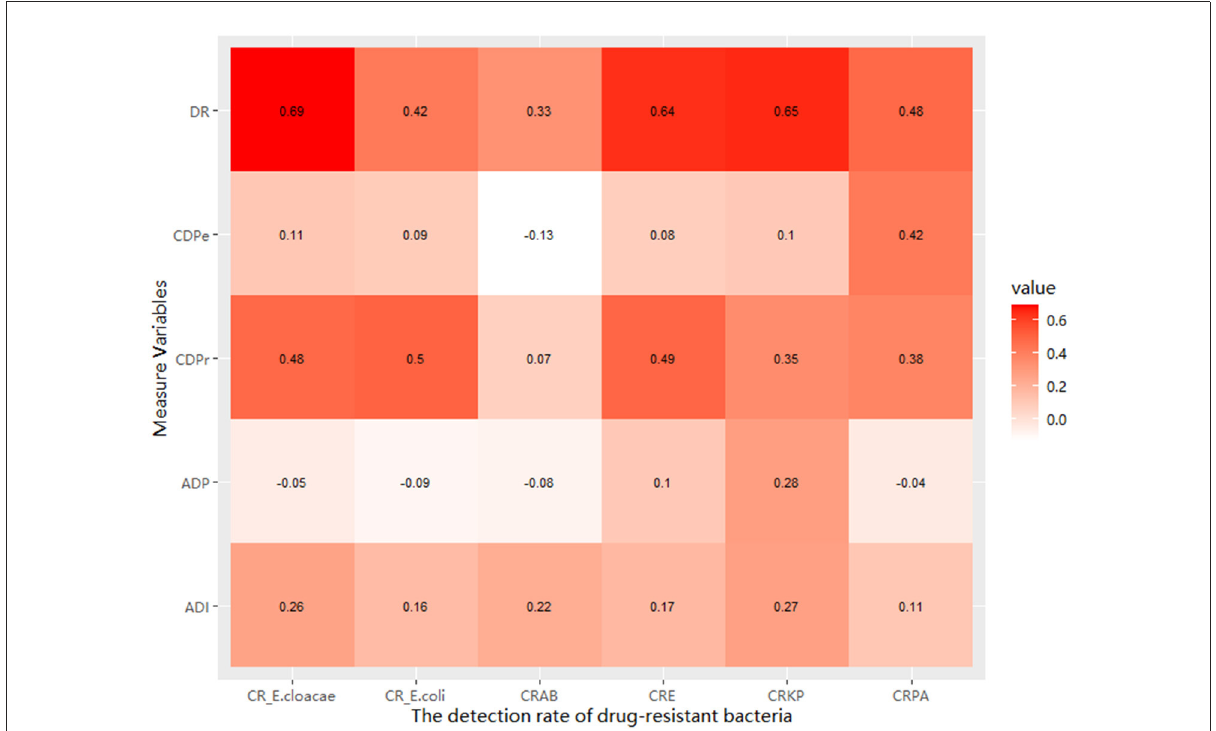
FIGURE3 The relationship between the detection rate of GNRB and the discovery rate and the measured drug use variables.